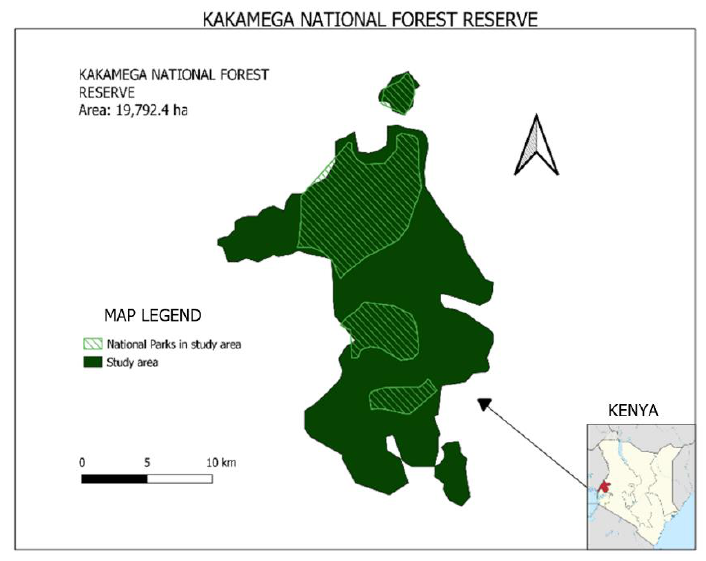
Figure 1. Map of Kakamega National Forest Reserve Ecosystem .